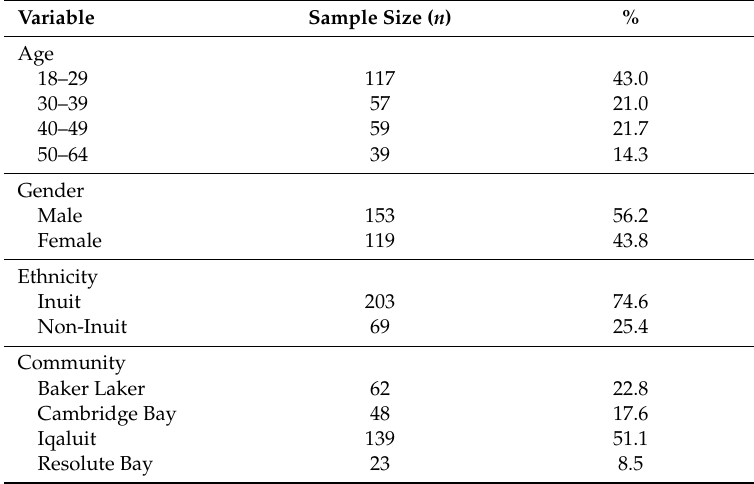
Table 2. Demographic Profiles of research participants (sample size n =